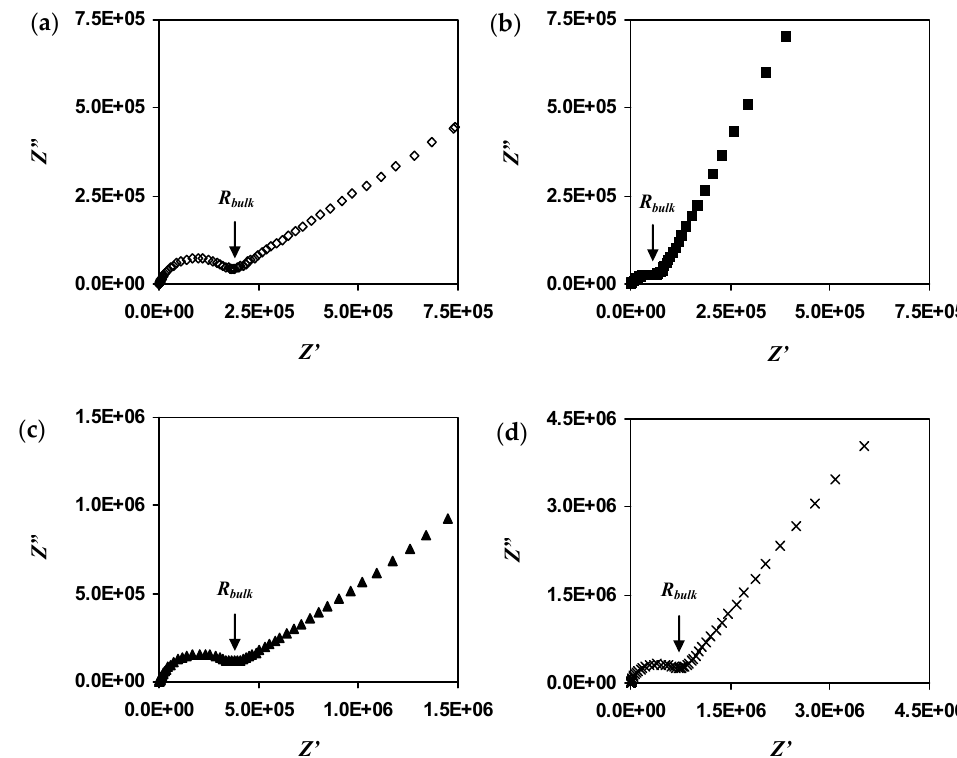
Figure 4. Nyquist plot of the Li 1+x Al x Ti x Sn 2-2x P 3 O 12 with x equal to ( a ) 0.2, ( b ) 0.4, ( c ) 0.6 and ( d ) 0.8 sintered at 650 °C.